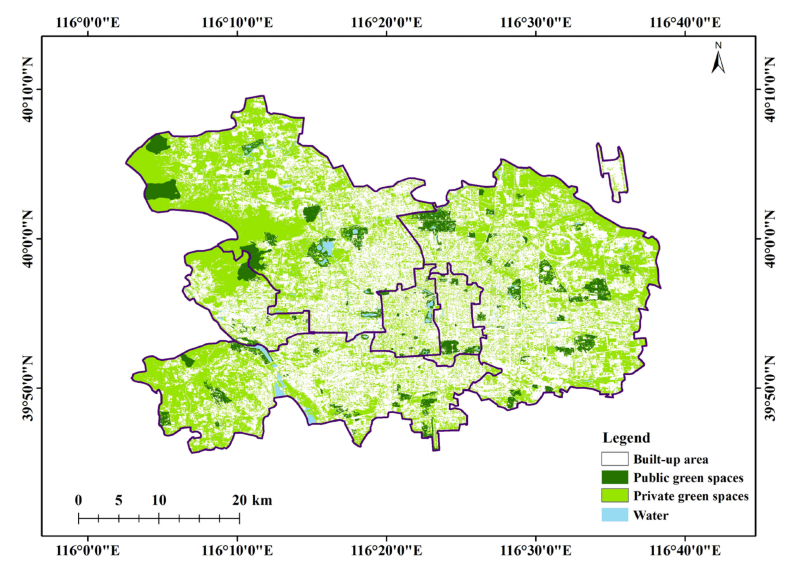
Figure 14. Distribution of public and private green spaces in